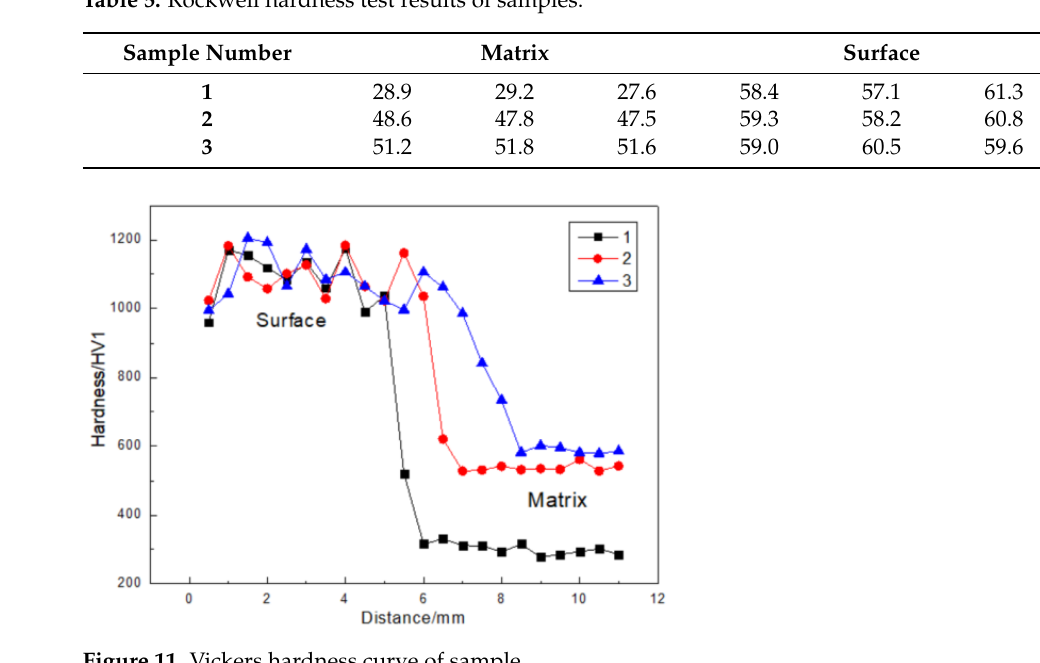
Table 6. Impact test